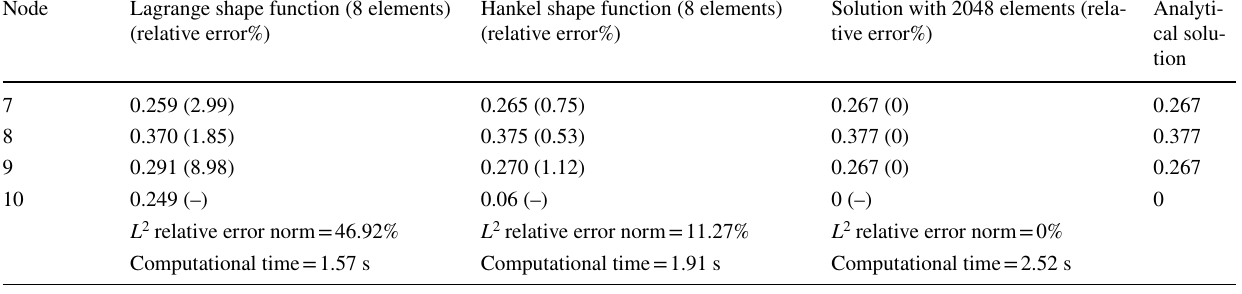
Analyti- cal solu- tion